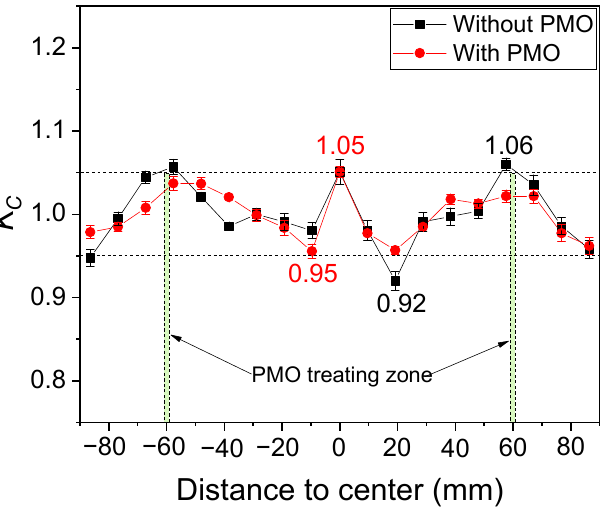
Figure 5. Macrosegregation in radial direction of No.11 billet sample.